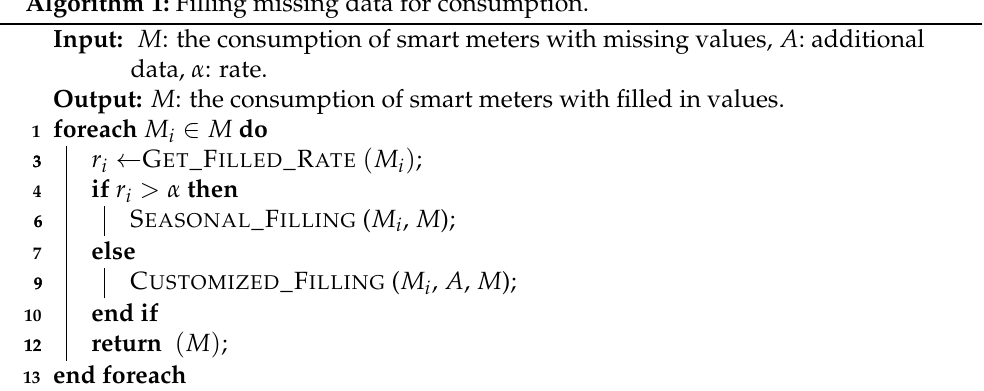
Algorithm 1: Filling missing data for consumption.